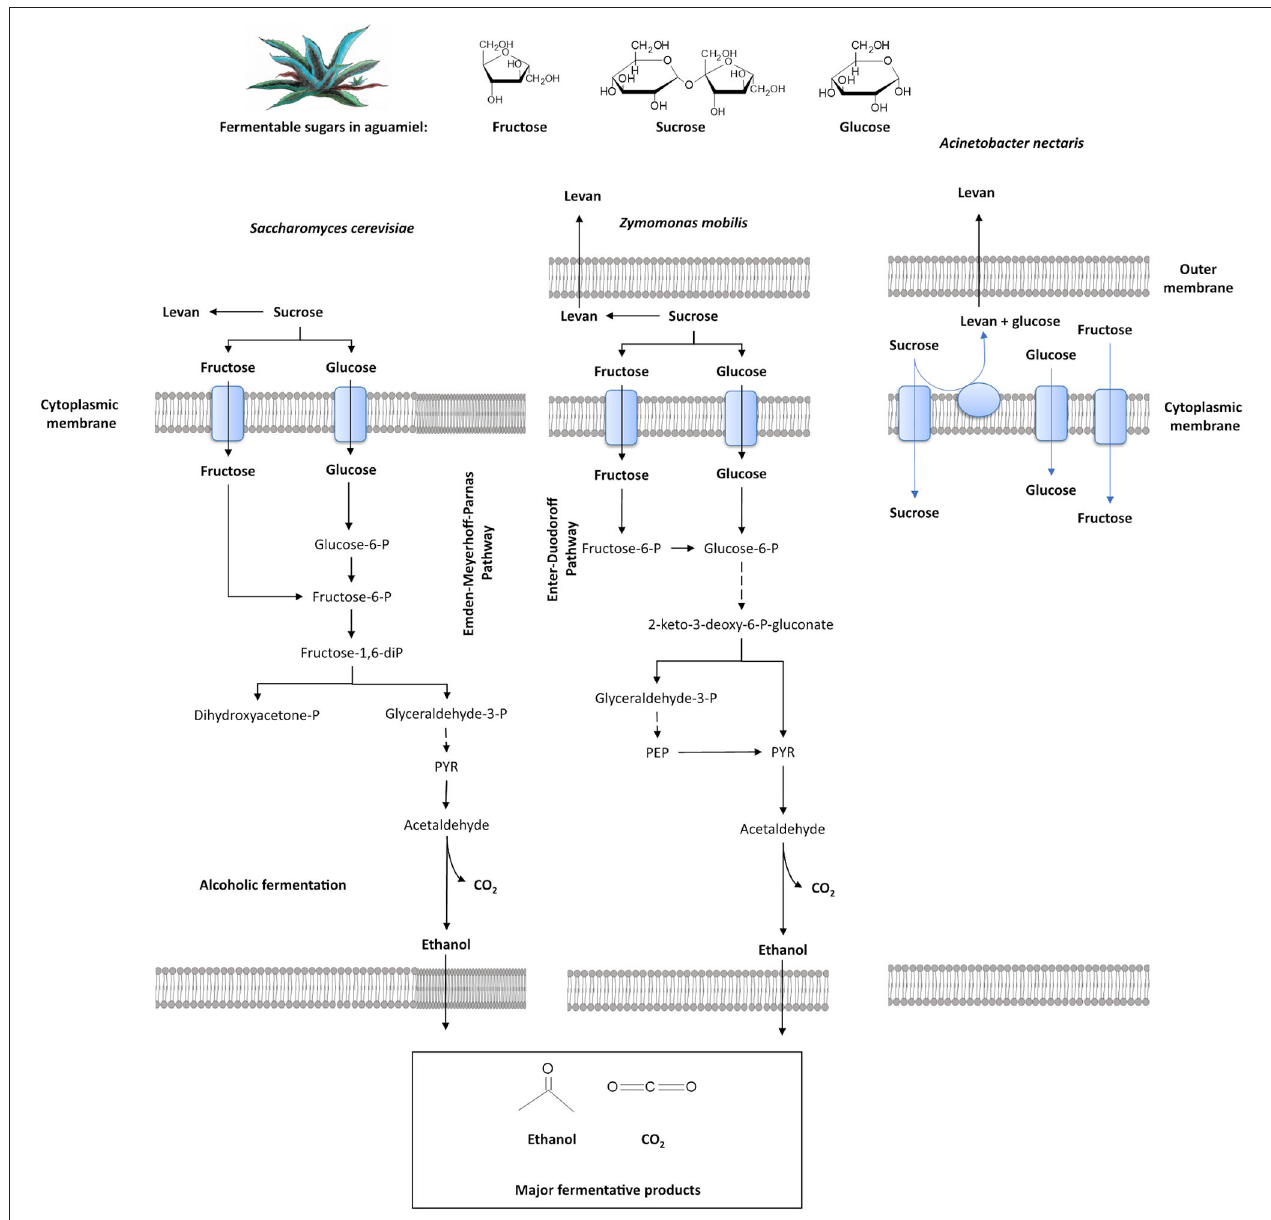
FIGURE 4 | Schematic representation of key metabolic pathways from the possible microbial essential core for pulque fermentation: The role of Saccharomyces cerevisiae, Zymomonas mobilis, and Acinetobacter nectaris. Sugar transporter systems are shown as blue structures in the cytoplasmic membrane. Continue arrows represent single metabolic enzyme-catalyzed reactions. Dotted lines represent several enzymatic reactions. Adapted from Swings and De Ley (1977), Sahm et al. (2006), Álvarez-Pérez et al. (2013), Walker and Stewart (2016), Weir (2016), Yang et al. (2016), Jansen et al. (2017), Chacón-Vargas et al. (2020), Rocha-Arriaga et al. (2020), and Carvalheira et al.